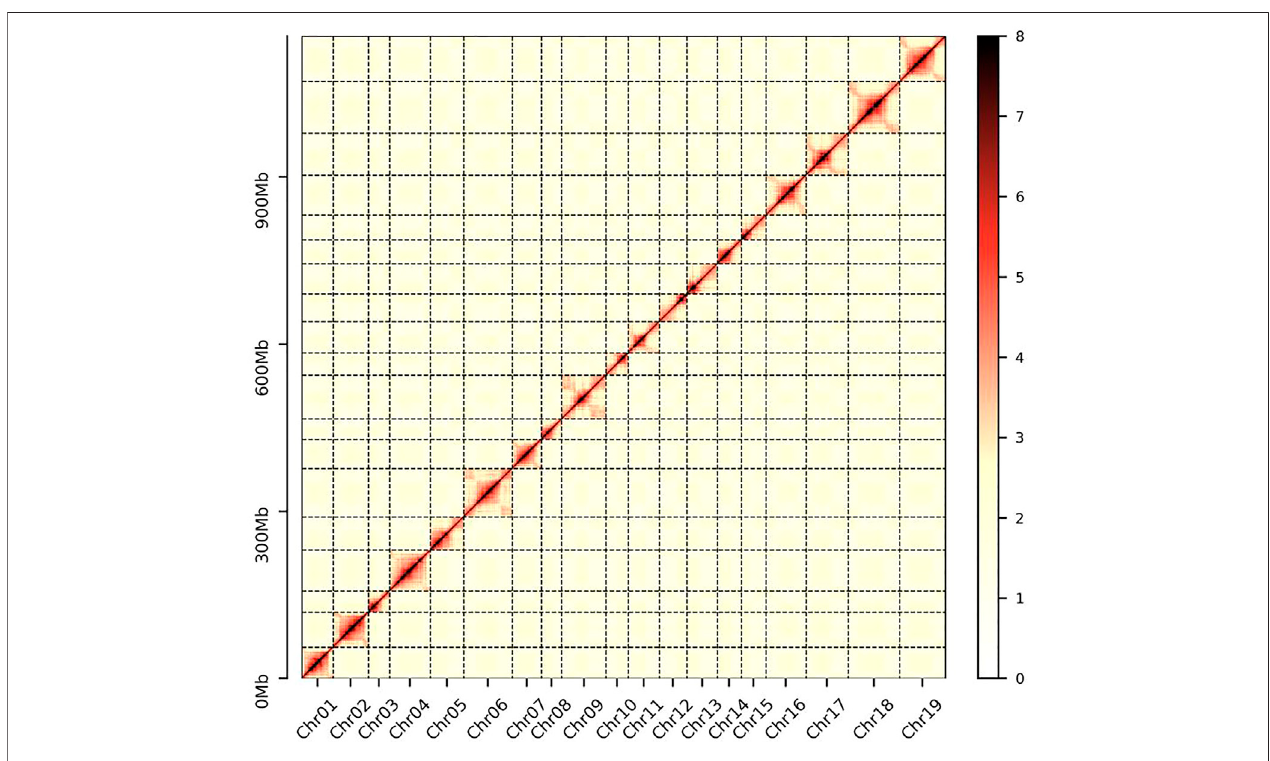
FIGURE 3 | Intensity signal heat map of the Hi-C chromosome. A higher value on the scale bar indicates a higher contact frequency.